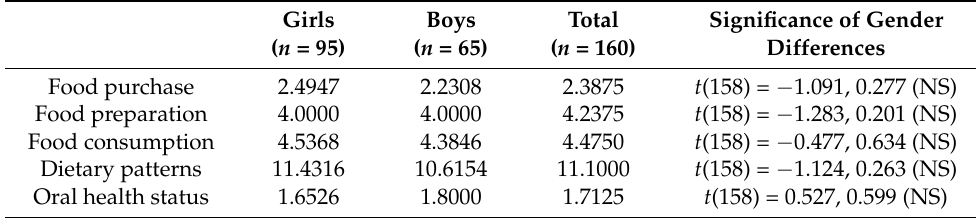
Table 3. Analysis for each measure by gender.